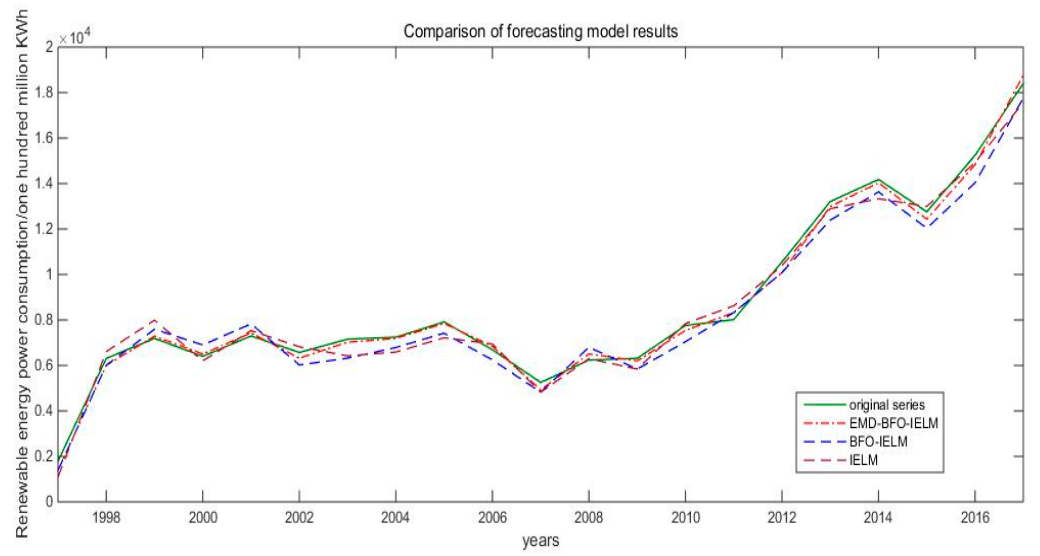
results of IMF2; ( c ) the predicted results of IMF3; ( d ) the predicted results of IMF4; ( e ) the predicted results of Resdiual.